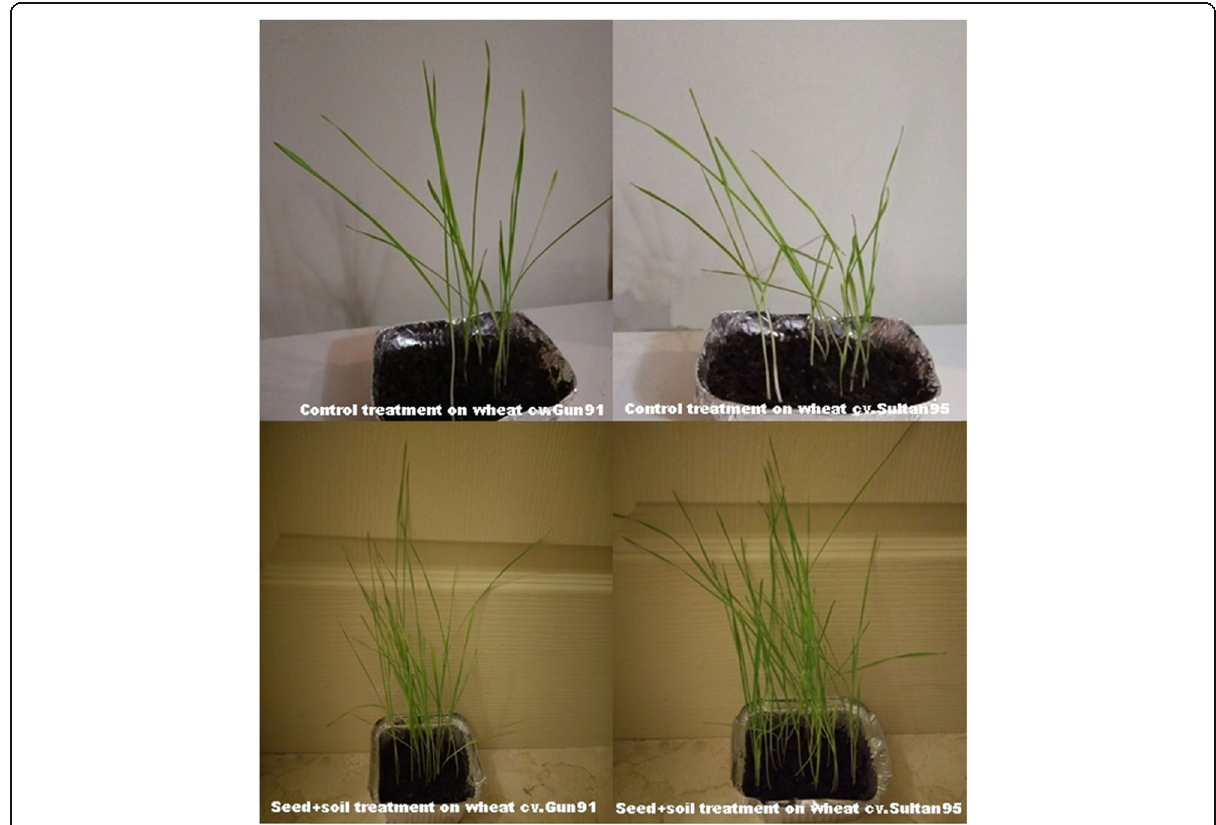
Fig. 3 Damping-off caused by F . graminearum in wheat cultivars after the seed + soil treatments with S . cerevisiae + S . fimicola at 1 × 10 9 spores/ ml and the control